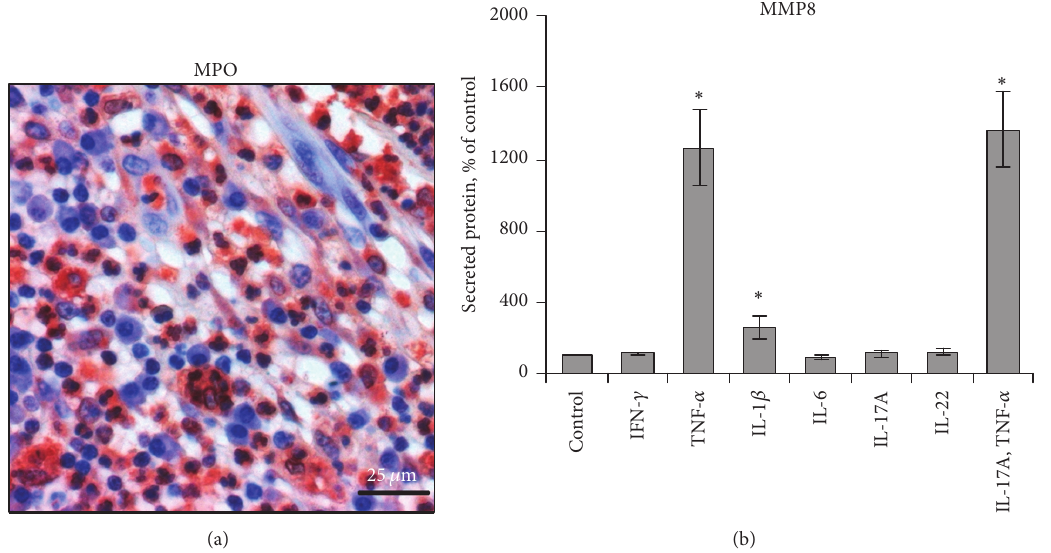
Figure 2: TNF- 𝛼 stimulates the release of MMP8 from neutrophilic granulocytes. (a) Biopsies from AI lesions were analyzed by IHC. Staining of myeloperoxidase, an enzyme abundantly expressed in neutrophilic granulocytes, in skin sections counterstained with hematoxylin is shown. Scale bar = 25 𝜇 m. (b) Human blood cultures were stimulated with the indicated AI-relevant cytokines or were left unstimulated (control) for 4h. MMP8 concentrations in cell-free supernatants were quantified by ELISA and demonstrated as percent of control. Data from 5 experiments are shown (mean ± SEM). Significance of differences between control versus stimulation groups was analyzed using the Wilcoxon matched-pairs signed-rank test (two-tailed; ∗ 𝑃 < 0.05 ).